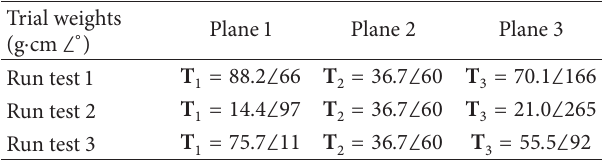
Table 2: Trail weights for the first two-order balancing. Trial weights Plane 1 Plane 2 Plane (g ⋅ cm ∠ ∘ )